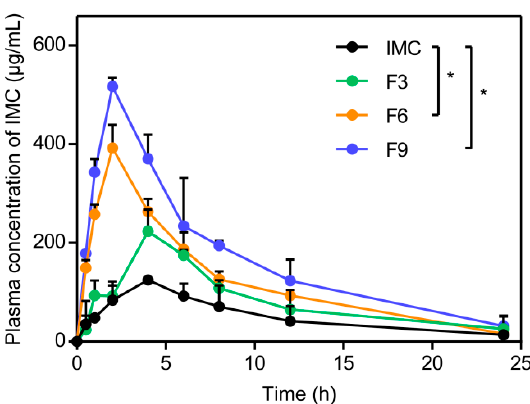
Figure 7. ( A ) Permeation profile of pure IMC and IMC–SDs in parallel artificial membrane permeability assay (PAMPA) experiment (mean ± SD, n = 3). ( B ) Permeation effective of IMC and IMC–SDs at 1.5 h, 2.5 h, and 3.5 h with the color becoming darker, respectively (mean ± SD, n = 3). ** p < 0.01, and *** p < 0.001 compared to the IMC group.